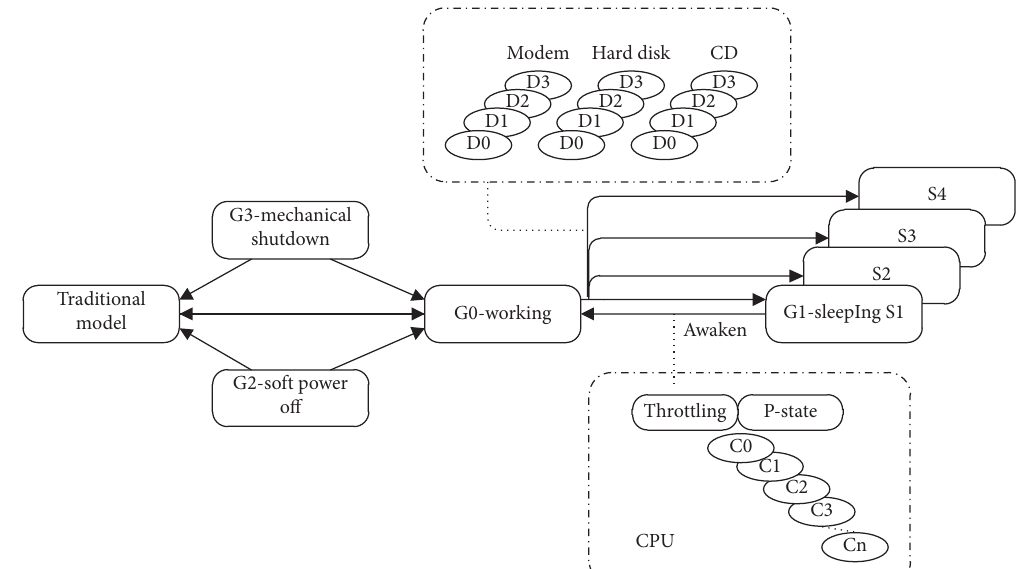
Figure 4: Power state transition diagram.